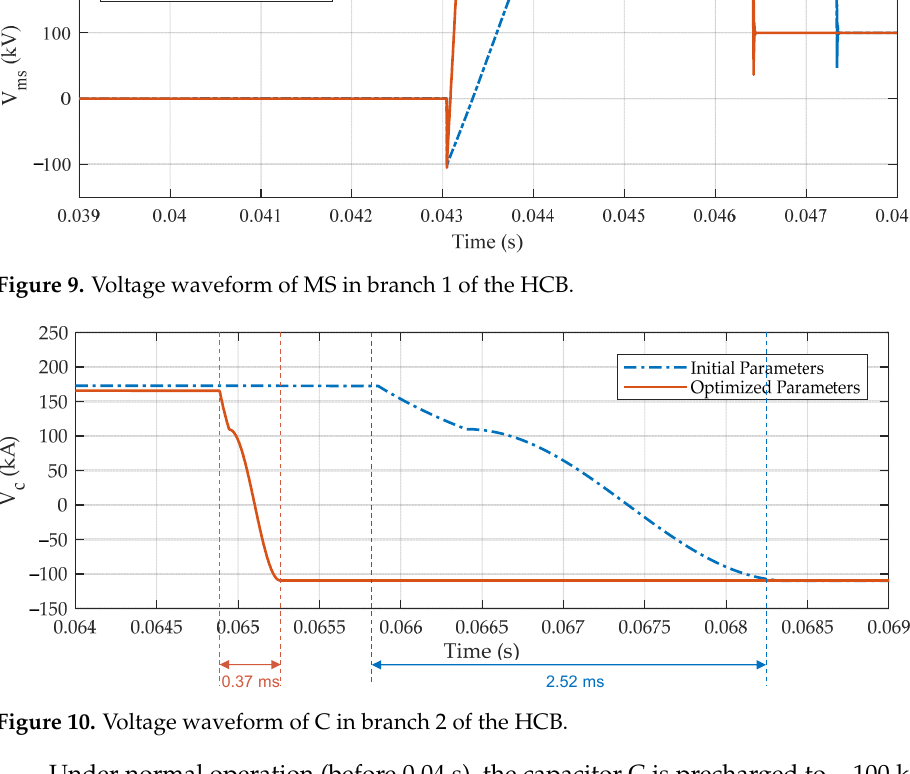
Table 5. Results of the optimal parameters for the HCB Component ( Unit )